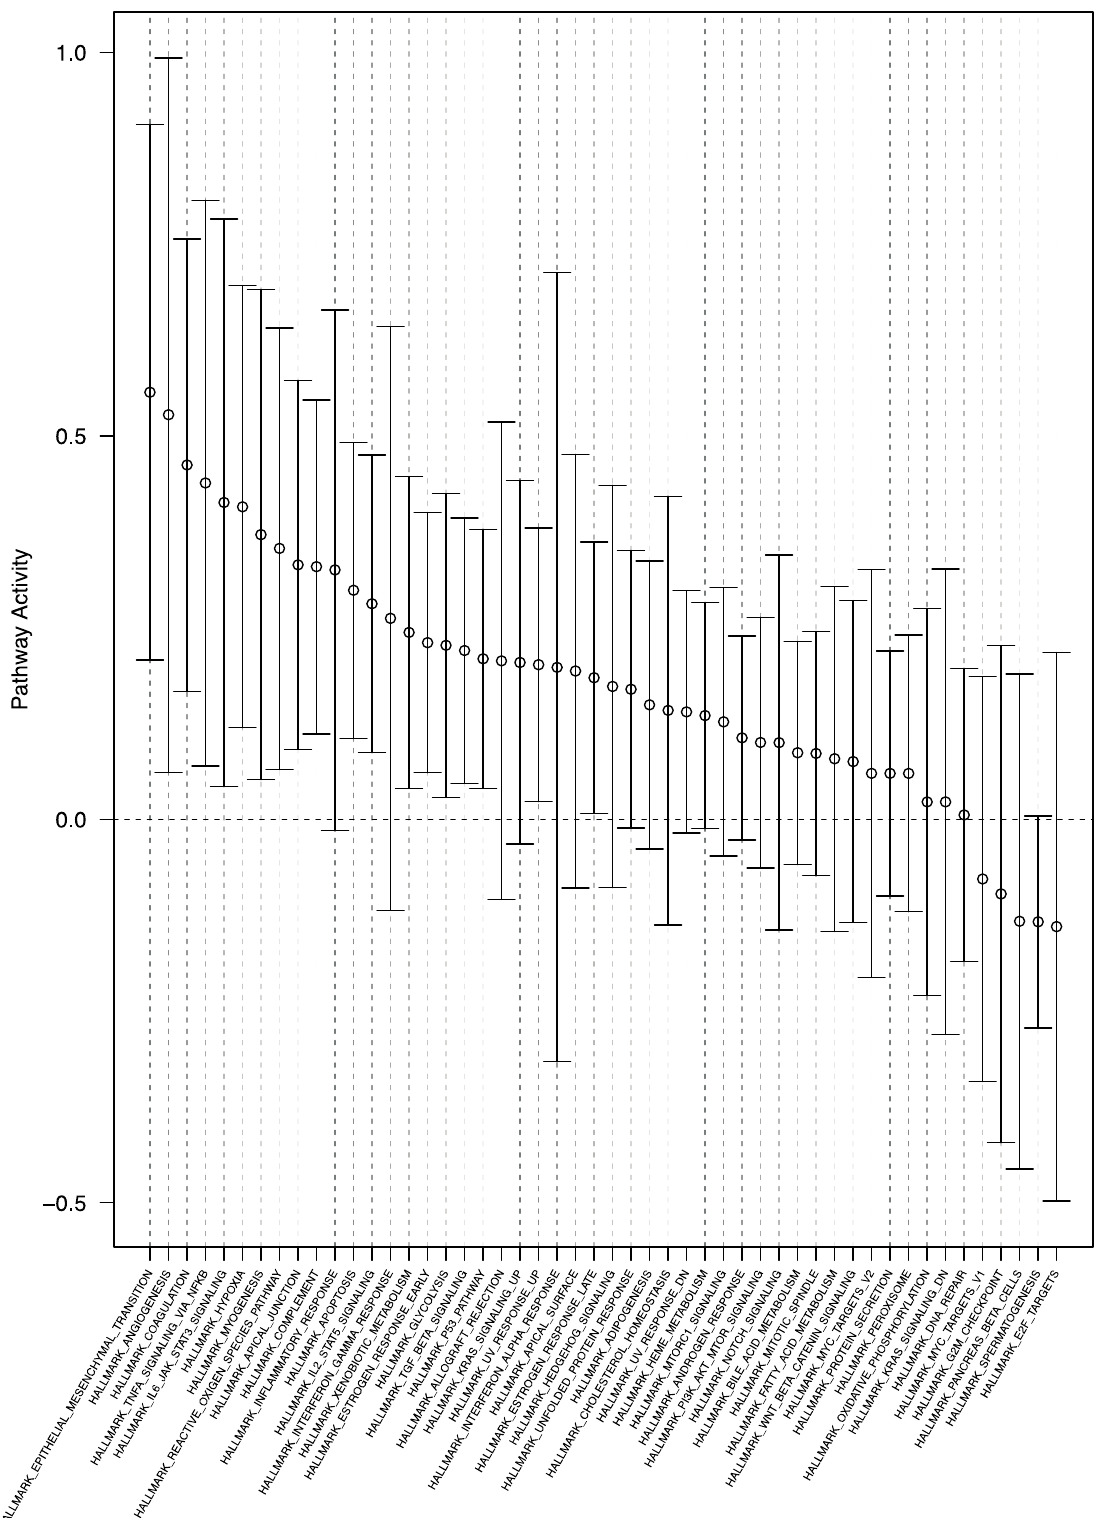
Figure 4. Pathway enrichment plot of the withinSVZ- samples vs. noSVZcontact- samples analysis. Gene set enrichment analysis of the withinSVZ- samples vs. noSVZcontact -samples showed differential enrichment of 27 gene sets ( p < 0.05, FDR < 0.25), which are shown on the x -axis. The relative gene set activity (log fold change) is displayed on the y -axis. The 95% confidence intervals are represented by the horizontal bars. Most gene sets were enriched in the withinSVZ -samples group, as shown by their positive log fold changes.